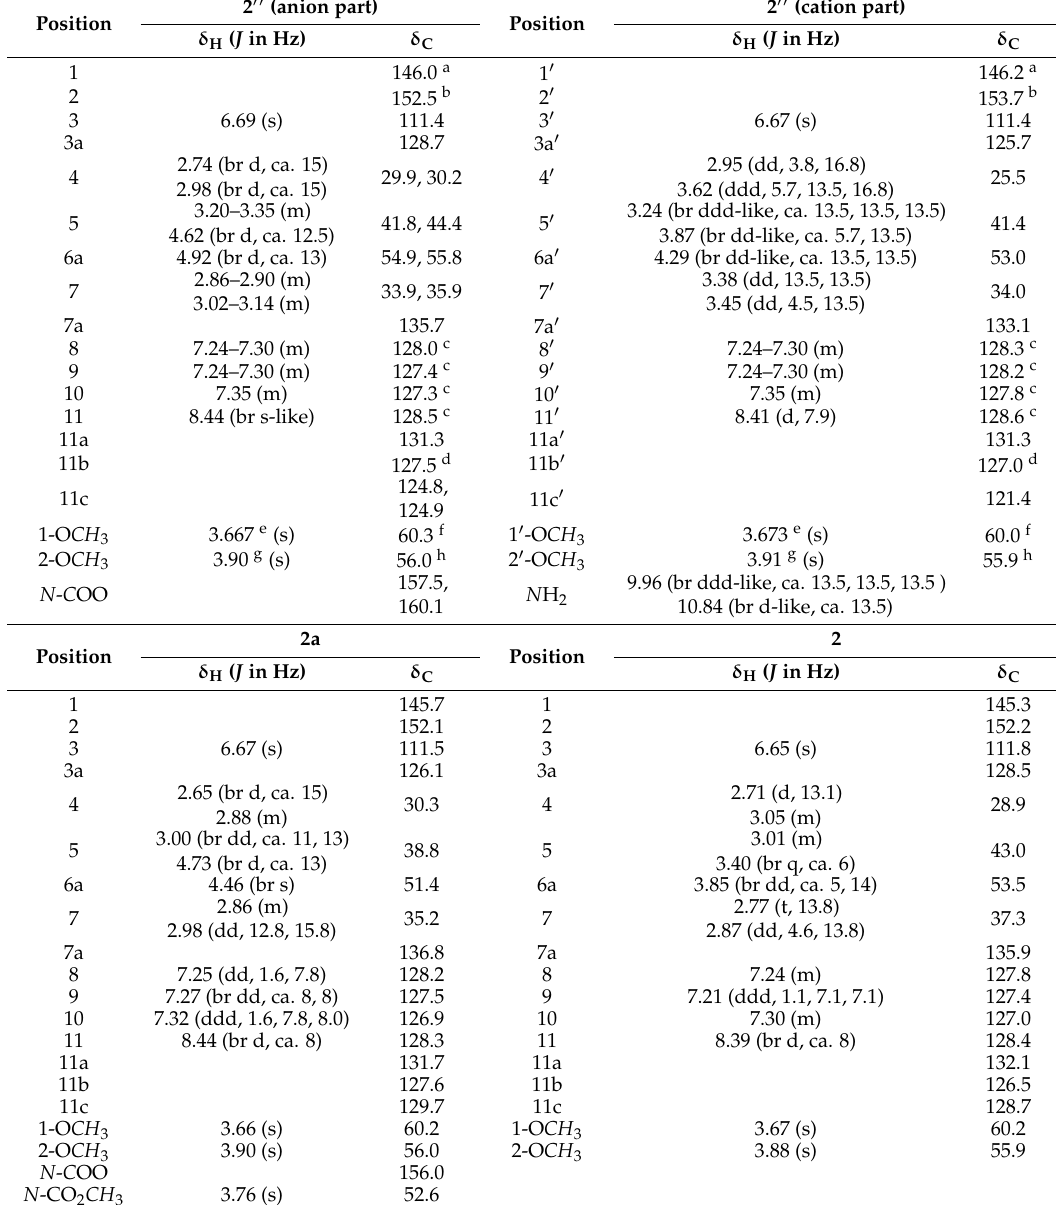
Table 6. 1 H- (800 MHz) and 13 C- (200 MHz) NMR data for 2 11 , 2a , and original alkaloid 2 in CDCl 3